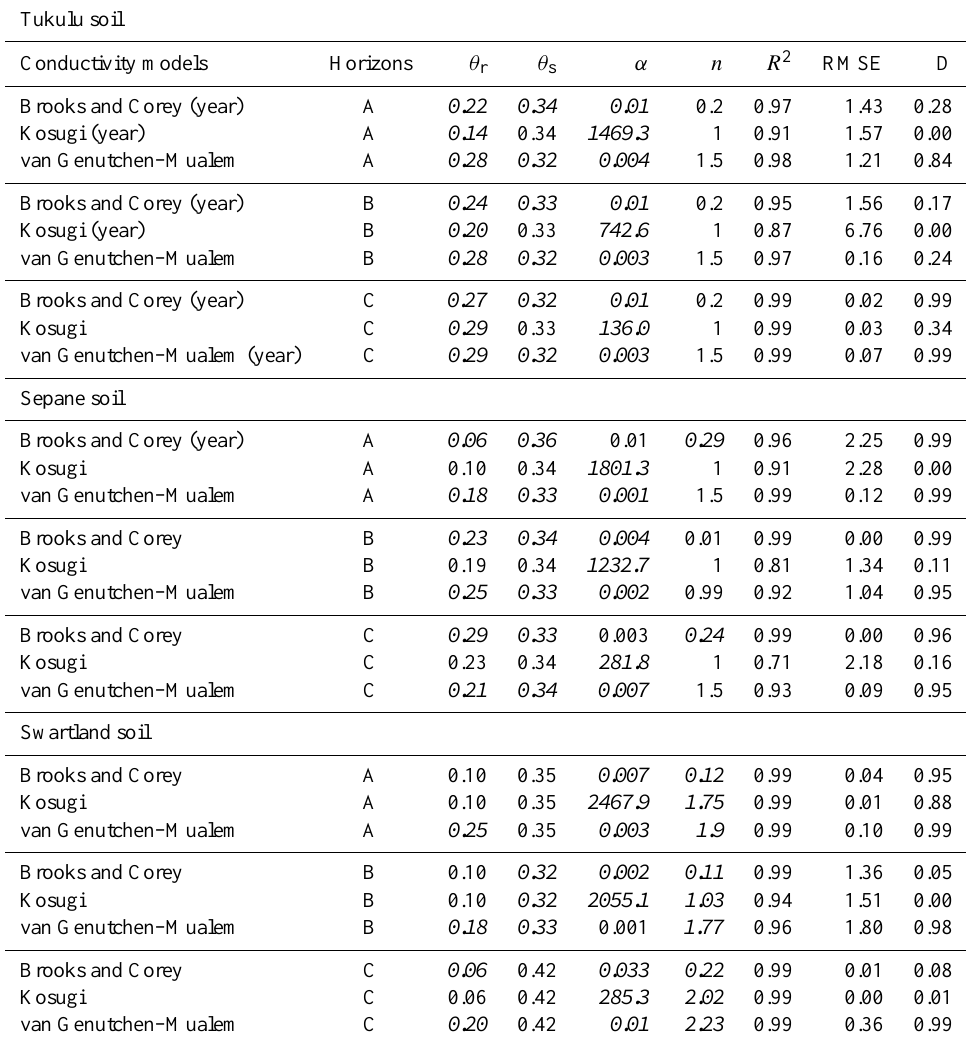
Table 4. Optimised models parameters with statistical indicators for the prediction of in situ hydraulic conductivity functions of the Tukulu, Sepane and Swartland soil horizons using